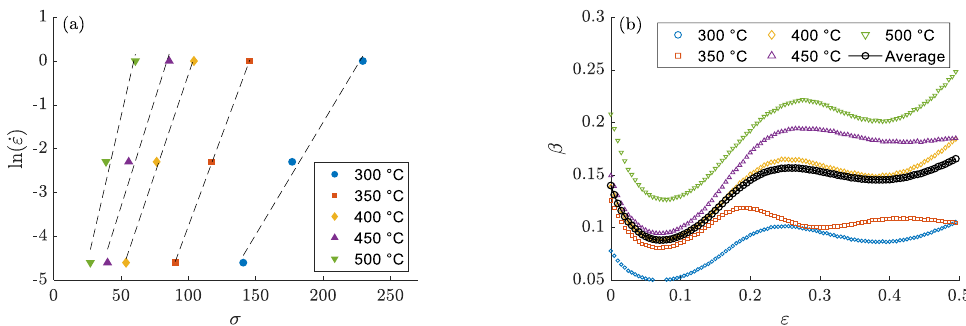
Figure 2. ( a ) The linear plots for determining β , and ( b ) determined values of β and their T -averaged as functions of strain.